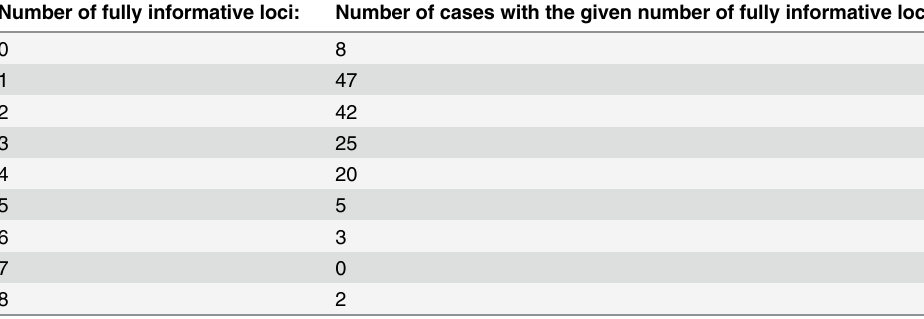
Table 1. Number of fully informative loci in 152 (near) triploid cases with vesicular chorionic villi, ana- lyzed along with a maternal sample. Number of fully informative loci: Number of cases with the given number of fully informative